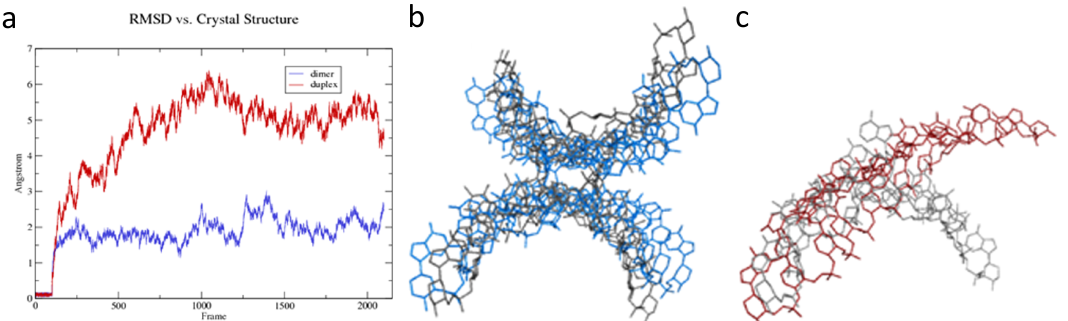
Figure 5. An individual homo-DNA duplex unwound during MD simulation, whereas the dimer of duplexes that was found in the crystal did not. ( a ) The dimer of duplexes remained stable during the simulation after initial relaxation, staying within ~2 Å root mean square deviation (RMSD) of the crystal structure (blue curve). A single duplex removed from the dimeric context, in contrast, diverged from the original conformation by > 5 Å RMSD (red curve). ( b ) The structure of the dimer of duplexes, viewed looking down the dyad axis. Shown in gray is the crystal structure, and in blue, the conformation after simulation in solution. ( c ) As in ( b ), but showing the increased unwinding of the isolated duplex during the simulation (in